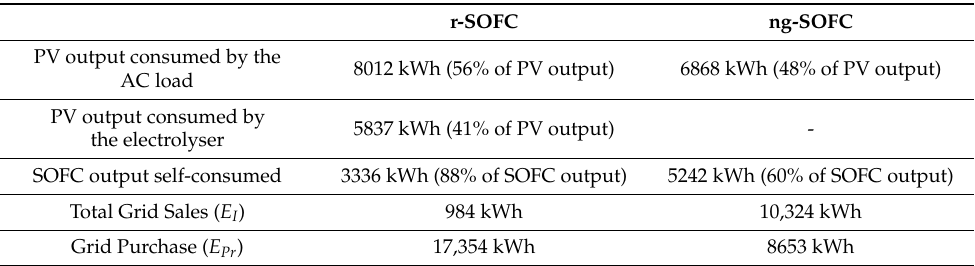
Table 4. Energy flows in NM